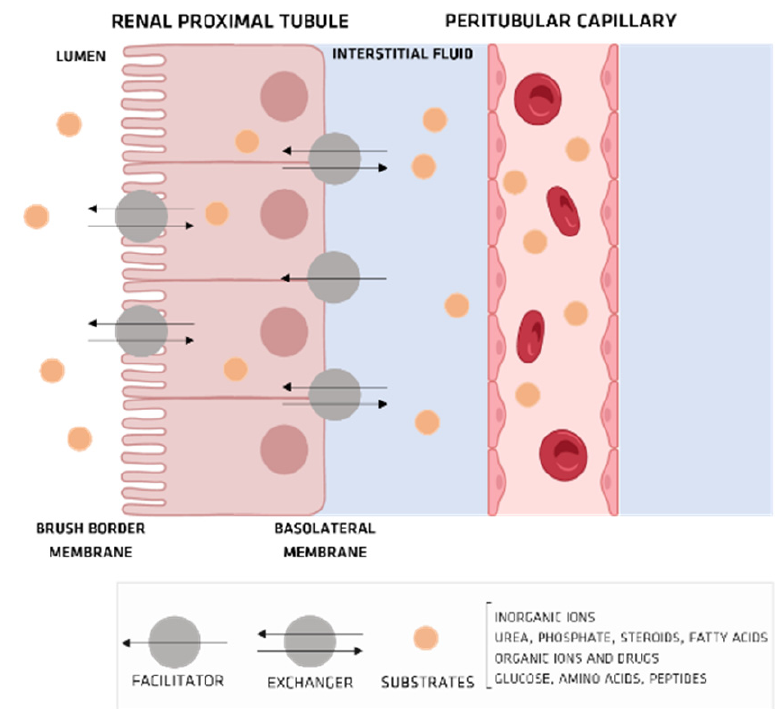
Figure 6. The roles of transporters in the human kidney.